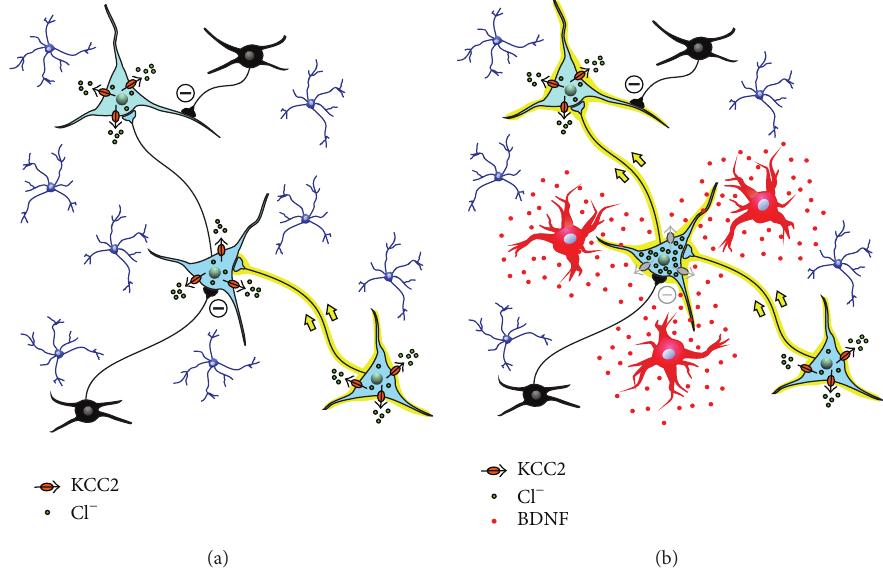
Figure 1: Microglia control neuronal network excitability via secretion of BDNF. The left panel illustrates a schematic neuronal network in the mature CNS under normal conditions: microglia (blue ramified cells) are in their resting state; small inhibitory interneurons release GABA or Gly to repress the flow of signals across the network; normal KCC2 activity extrudes Cl − (black arrows) to maintain the Cl − gradient, and, consequently, Cl − flows in through GABA A R/GlyR channels to inhibit activity. The right panel illustrates the same network after an external event has induced microglial activation (red cells) and the release of microglial BDNF: BDNF-TrkB signaling causes downregulation of KCC2; Cl − accumulates in neurons and the Cl − gradient collapses; GABA A R/GlyR-mediated inhibition is less effective in controlling neuronal firing, and previously silent neuronal pathways are unmasked (yellow